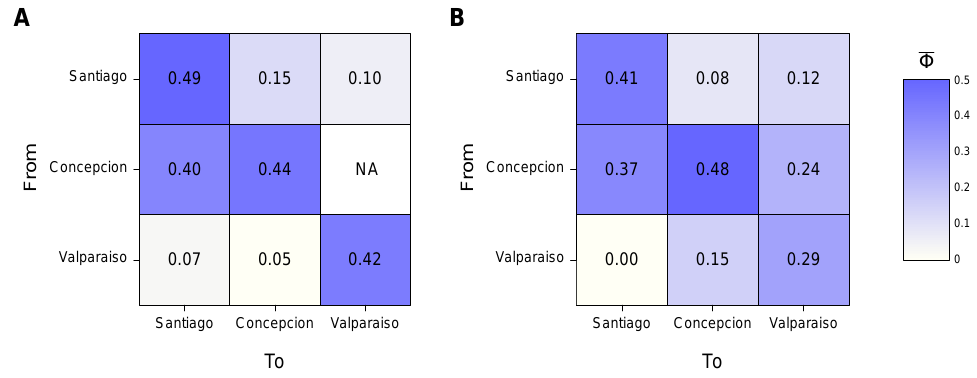
Figure 4. Intra-city and inter-cities socio-spatial interactions analysis. The index values are based on spatial ( A ) and social ( B ) interactions between locations in the same city (diagonal) or from one city to another. There were not enough data available (NA) to measure the spatial interactions between Concepción and